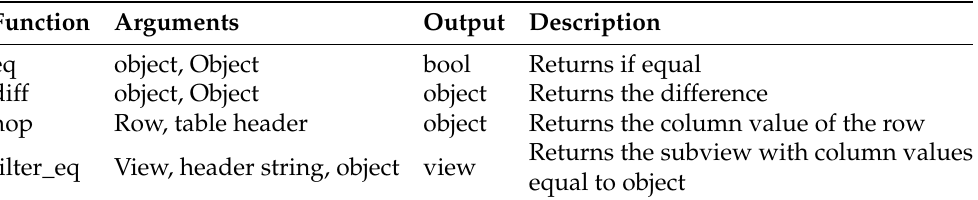
Table 3. Logic form function